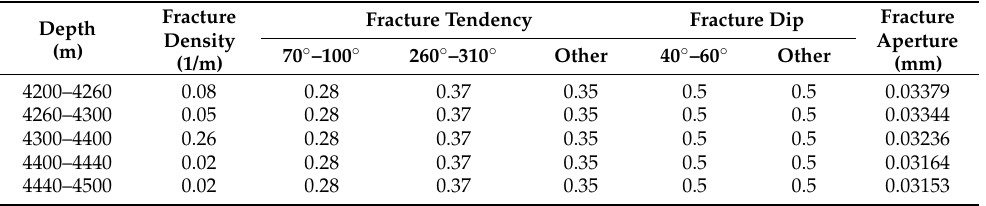
Table 3. Parameter values used for generating random fracture medium